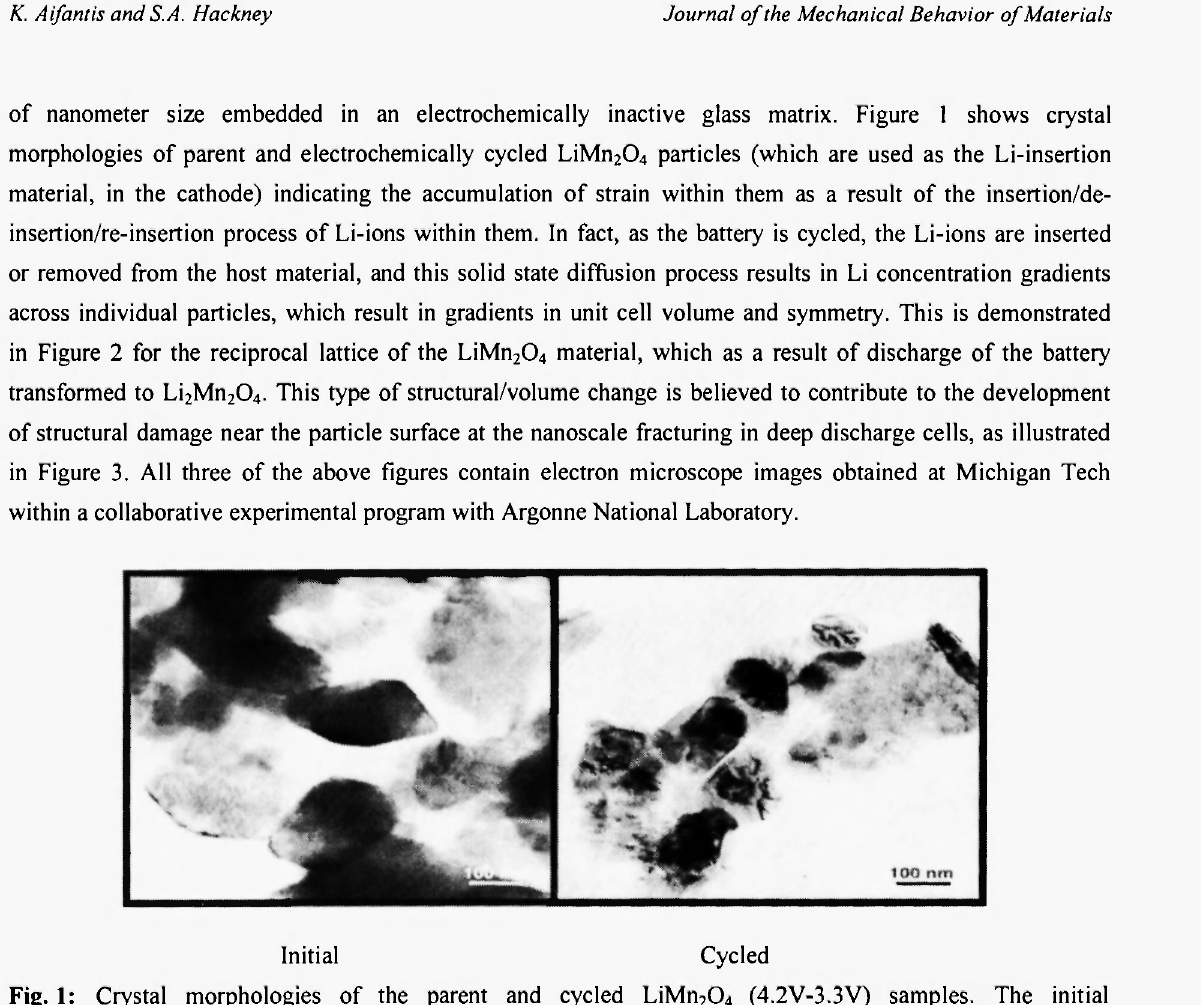
Fig. 1: Crystal morphologies of the parent and cycled LiMn 2 0 4 (4.2V-3.3V) samples. The initial morphology for the uncycled powder particles consists of single or bi-crystals of size 50nm